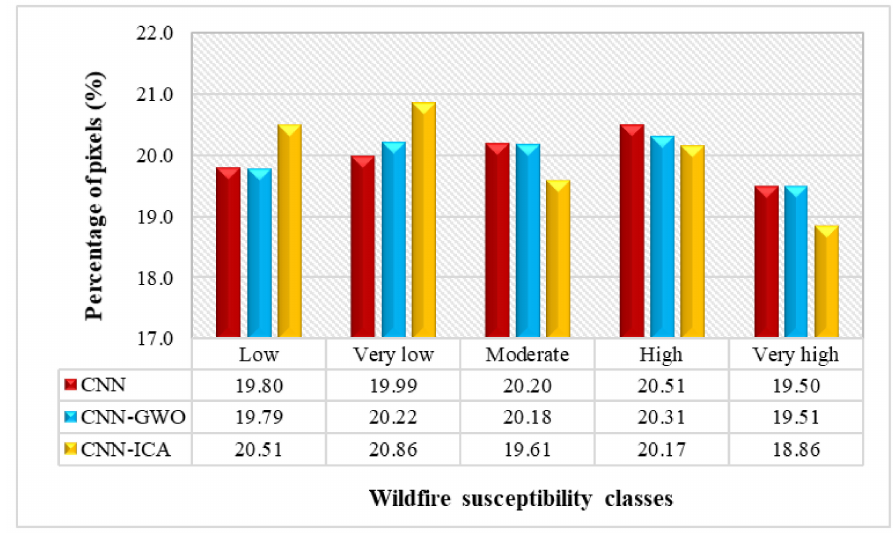
Figure 8. The distribution of wildfire susceptibility levels in the CNN, CNN-GWO, and CNN-ICA models.